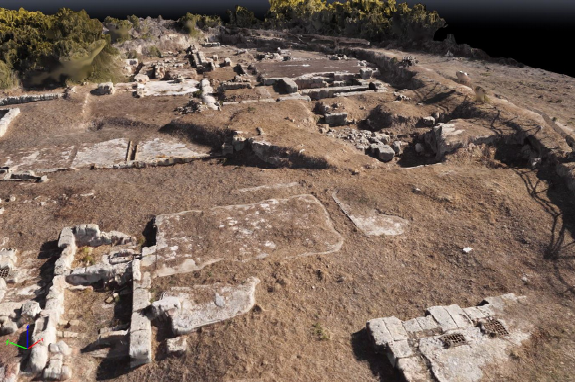
Figure 13. Detail of the textured 3D model of the Insulae II-III .